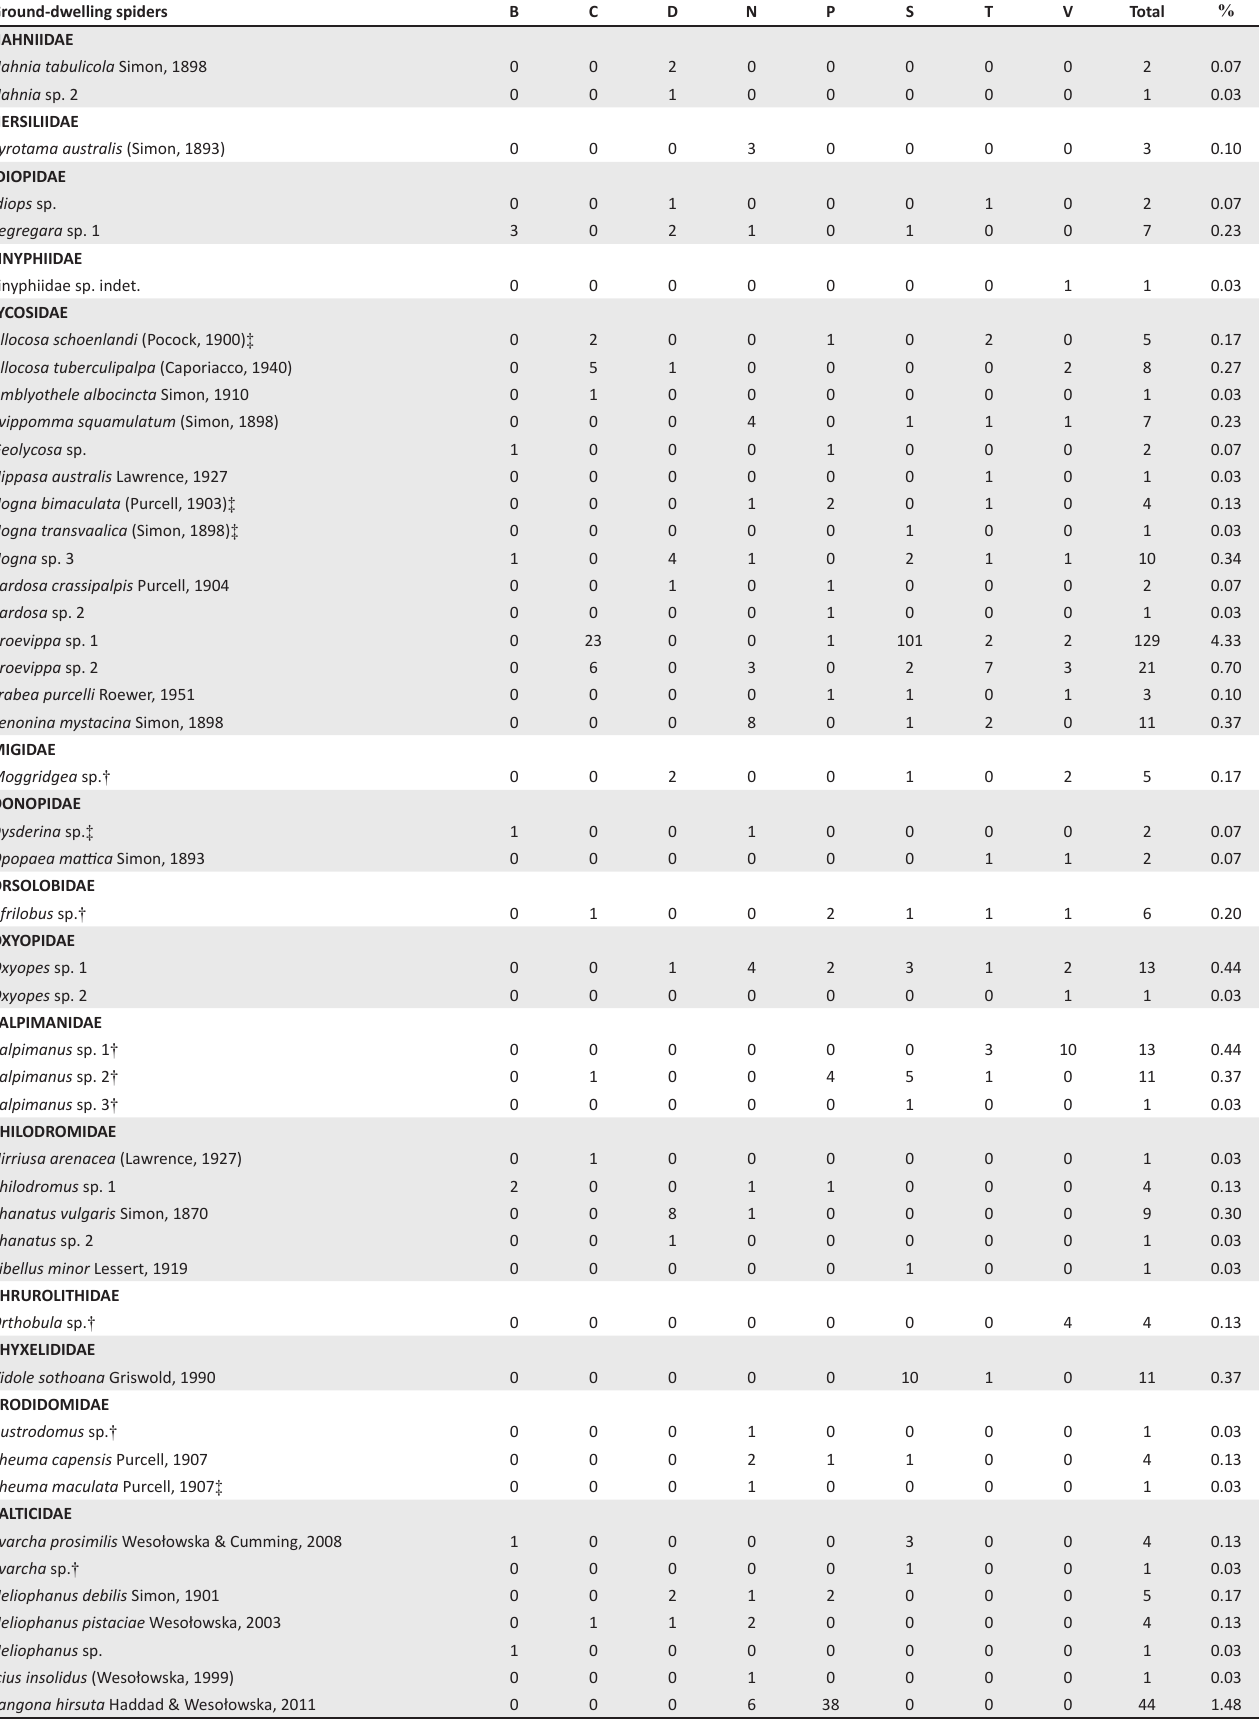
TABLE 1-A1 (Continues...): Ground-dwelling spiders collected by pitfall trapping from eight habitats in the Amanzi Private Game Reserve. Ground-dwelling